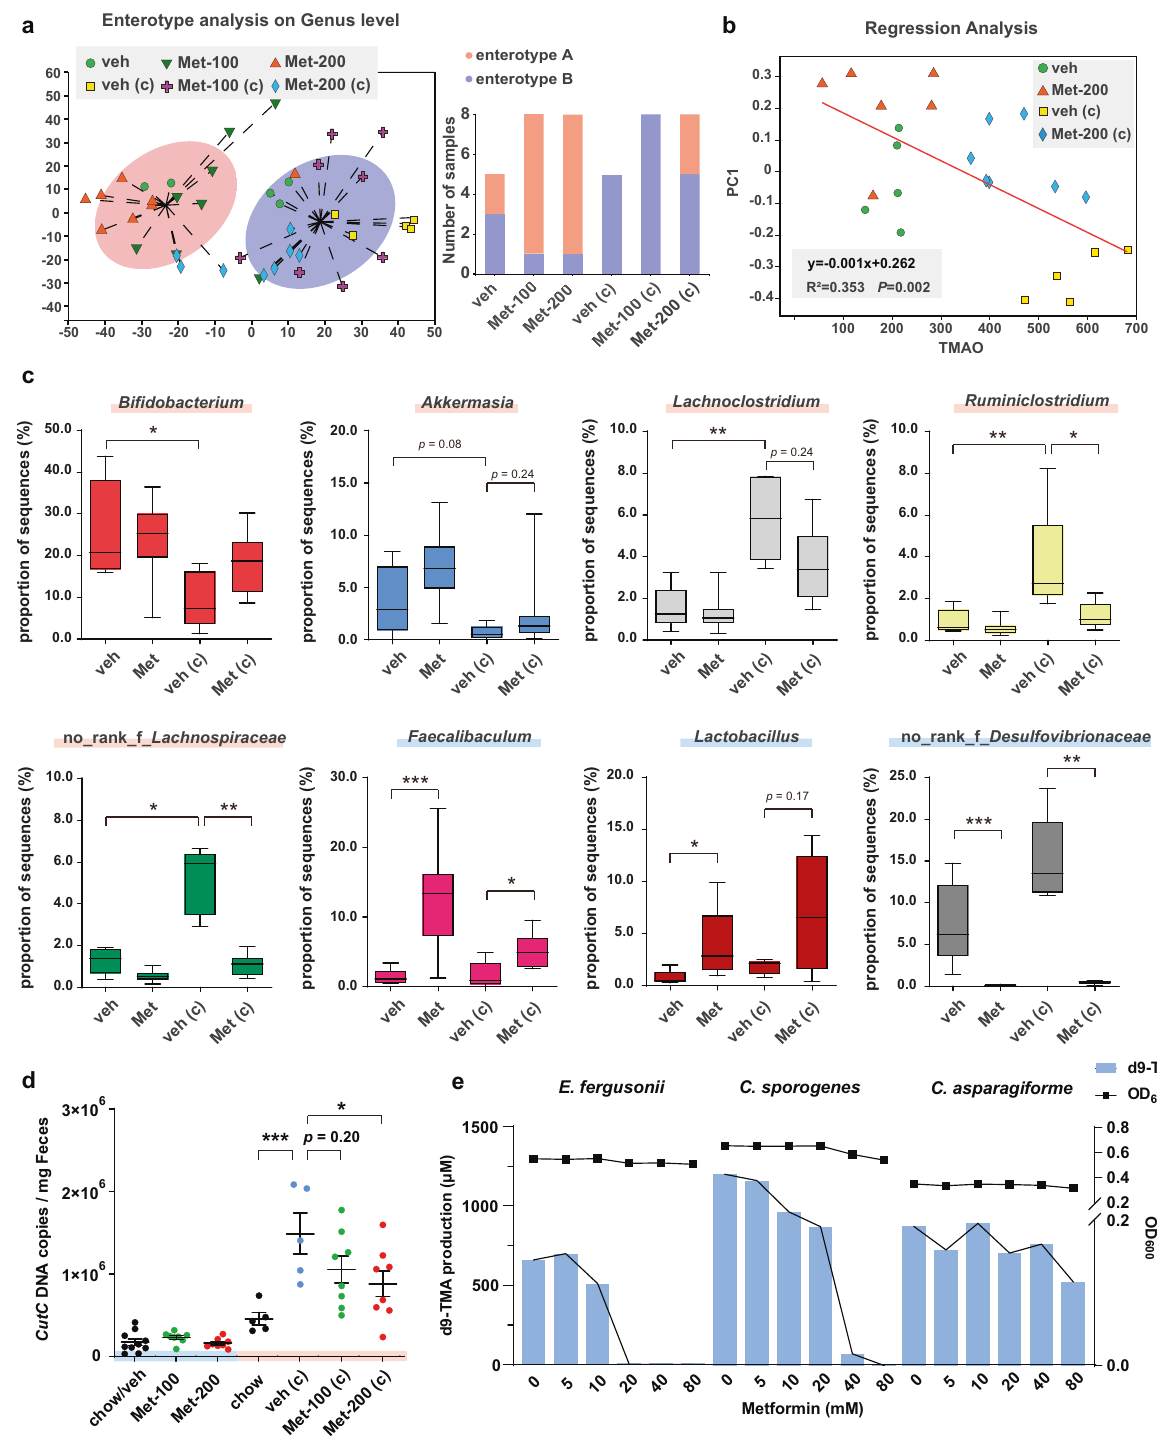
Fig. 2 Metformin treatment altered composition of gut microbiota and inhibited TMA production from choline. a Effects of metformin on enterotype of C57BL/6J mice fed with chow or choline diet. Samples were calculated using Jensen-Shannon distance and separated into two clusters by the PAM method. The left panel showed the clustering of two top principal components. b Linear regression analysis of the correlation between serum TMAO level and microbiota beta diversity based on OTU levels with bray curtis algorithm. c The abundance of signi fi cant different genera among four groups. Metformin, 200 mg/kg. Boxes show the median with interquartile ranges, whiskers show the minimum and maximum values. p -values are from Kruskal – Wallis H test (* p < 0.05, ** p < 0.01, *** p < 0.001). d The abundances of cutC gene in fecal samples were measured by qPCR. veh/veh (c), n = 5; chow, n = 5; Met-100/Met-100 (c), n = 8; Met-200/Met-200 (c), n = 8. The error bars represented the mean ± SEM (* p < 0.05, *** p < 0.001). e Effects of metformin on TMA-producing bacteria under anaerobic condition. The production of d9-TMA from d9-choline (bar) and OD 600 (line) were measured after metformin treatment for 24